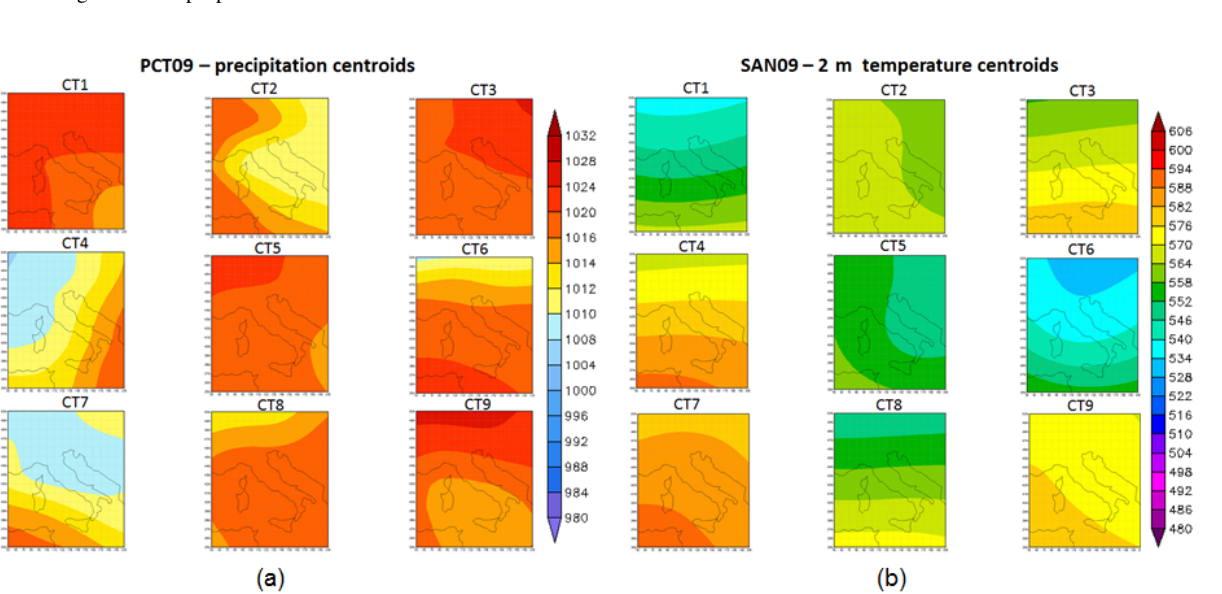
Figure 2. Centroids of PCT09 classification implemented on mean sea level pressure (Fig. 2a, values in hPa on the right side of color bar) computed for ground-level precipitation and (a) SAN09 classification implemented on geopotential height at 500hPa (Fig. 2b, values in tens of metres on the right side of color bar) computed for 2m temperature (b) . Each map represents the central value of the circulation type as a result of the calibration